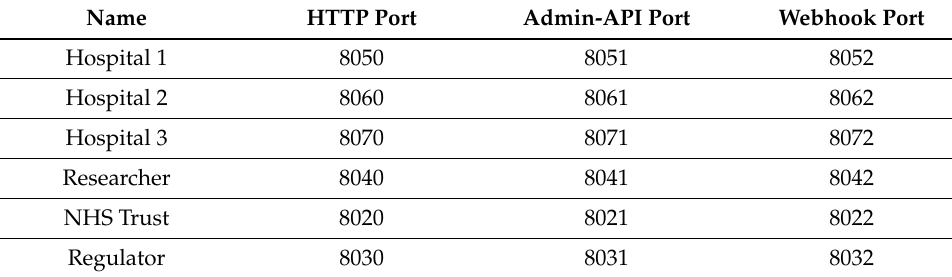
Table 1. Participating entities communication details.